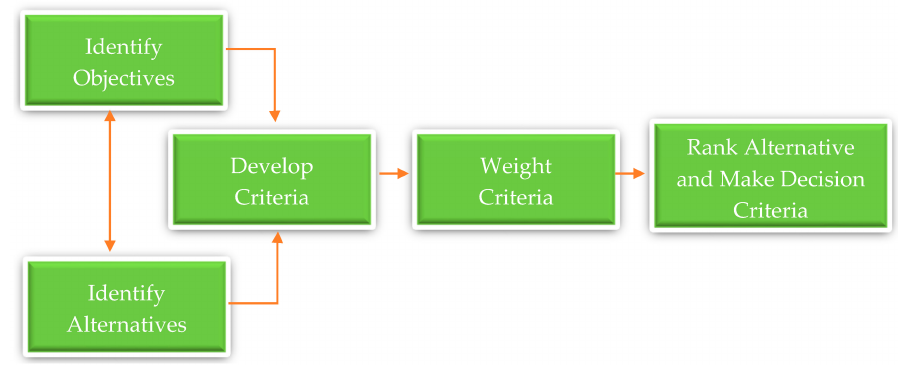
Figure 2. A generic process of MDCD